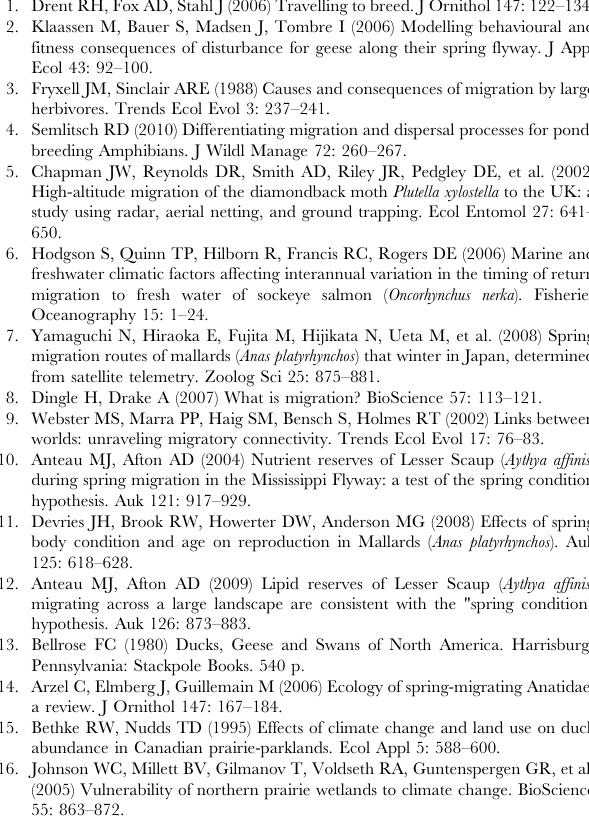
Table S2 Parameter estimates, standard errors, and associated test statistics for nonlinear mixed-effects models that quantified migration chronology of